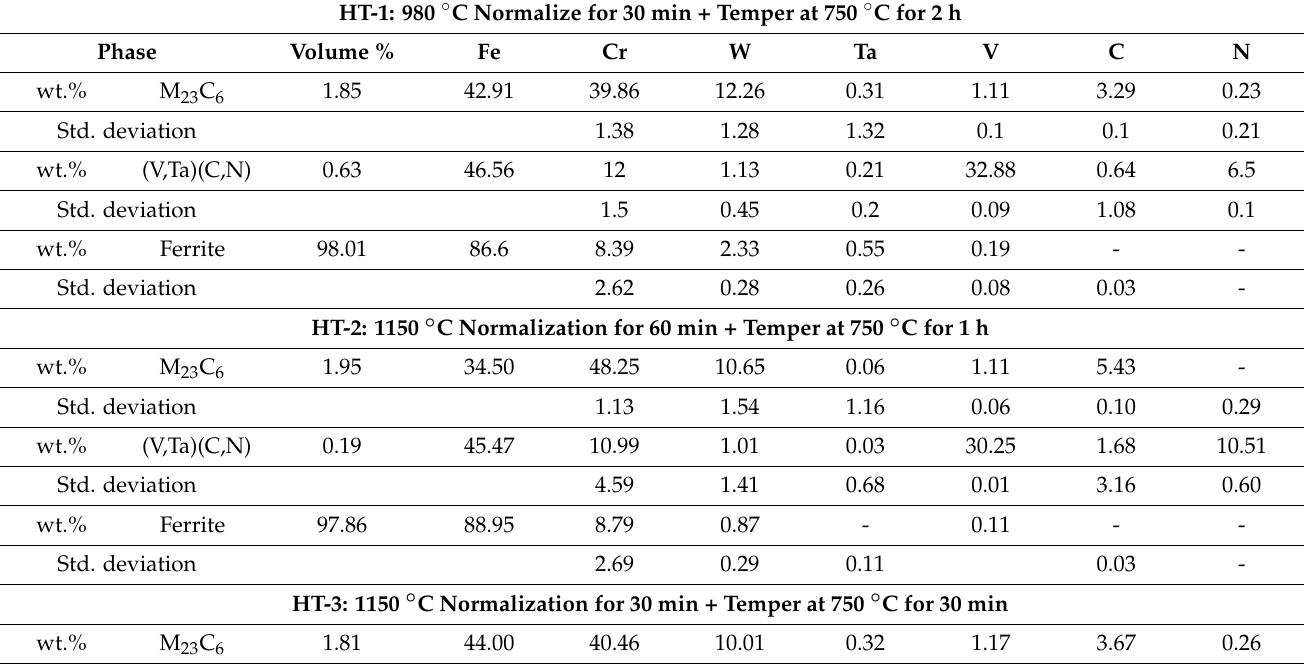
Table 4. Chemistries quantified from the STEM EDS